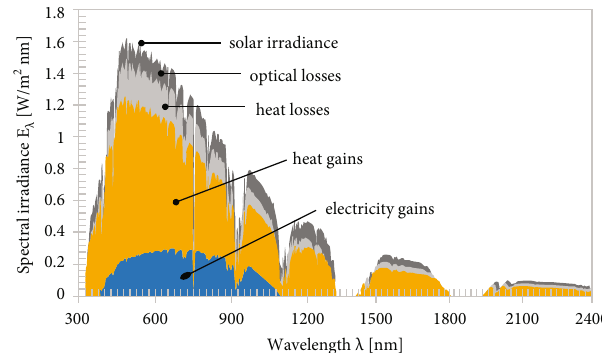
Figure 1: Solar spectrum on PVT collectors (PV 20% and thermal 60%)